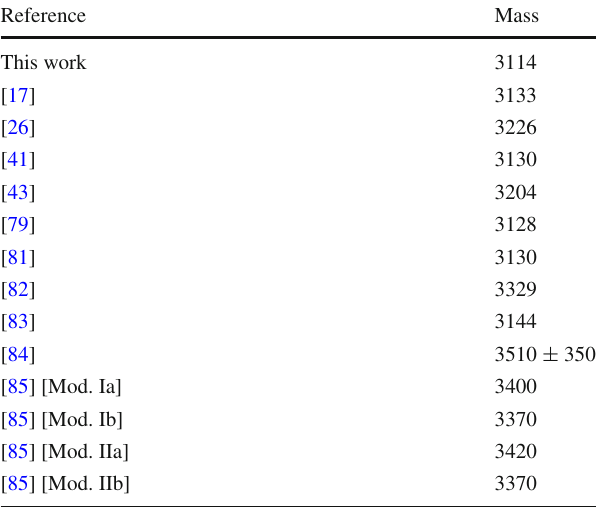
Table 4 Comparison of cc diquark masses of this work and results from other works. All diquarks are considered to be in the ground state N 2 S + 1 L J = 1 3 S 1 . All results are in MeV